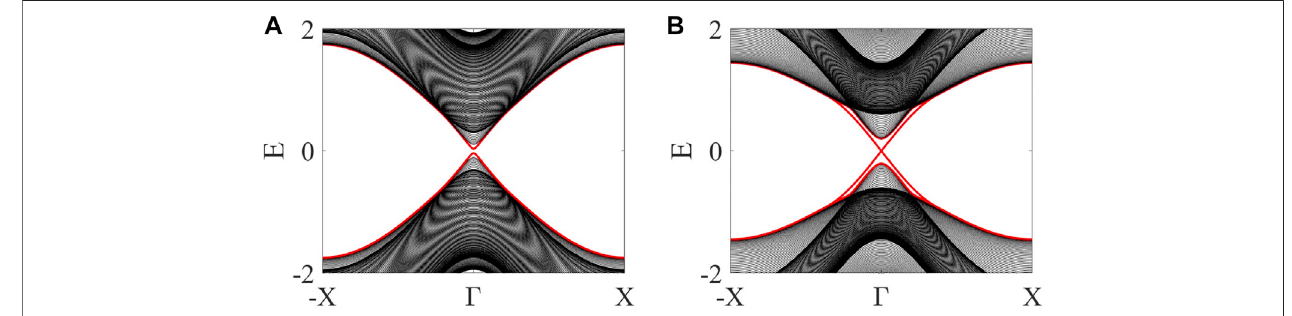
FIGURE 2 | (Color online) Bulk topological phase transitions induced by an out-of-plane Zeeman fi eld. Chosen parameters are: t = 1, m = 1.8, λ = 1, η = 0.2, N y = 100. (A) B z = 0.1, the edge spectrum remains gapped as B z is smaller than the critical value B c , Γ = 0.2. (B) B z = 0.4, with B z beyond the critical value, the edge spectrum becomes gapless, indicating the occurrence of a topological phase transition from a SOTI with corner states to a Chern insulator with chiral edge